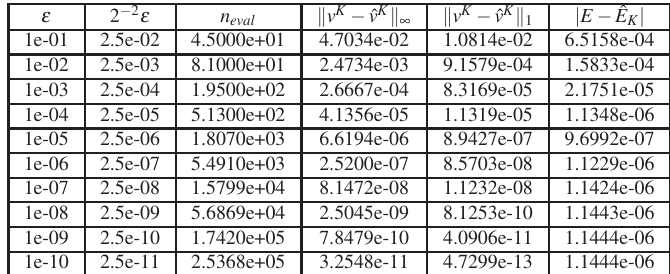
Table 11 Parameters as specified in Table 1 for f 2 , K = 15 and the polygonal rule. ε k = ε varies between 10 − 1 and 10 − 10